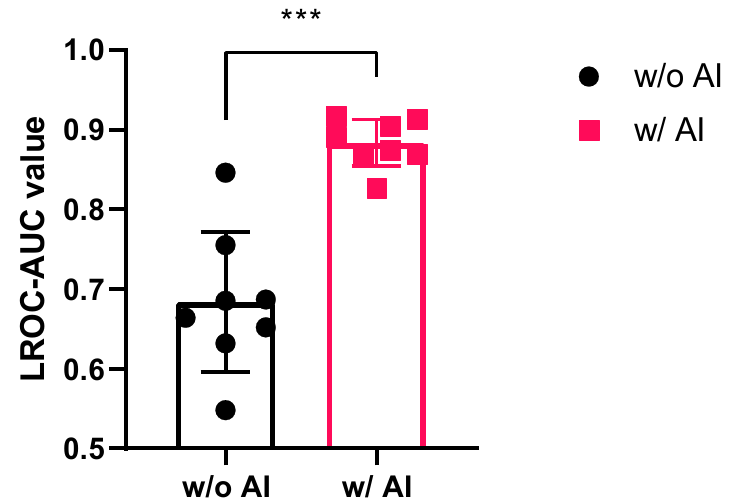
Figure 5. LROC-AUC value increased for AI-assisted CT screening. LROC-AUC value is calculated according to the LOS scores of the nodule, where the central point of each junior doctor’s mark of a suspicious nodule falls within the radius of an actual nodule based on the ground truth. The AUC values with and without the pre-engagement of AI algorithm in CT images’ recognition in CSH and TVGH were statistically analyzed. Data represent the mean ± SD. *** p < 0.001. LROC, localization receiver operating characteristic; AUC, receiver operating characteristic curve; LOS, level of